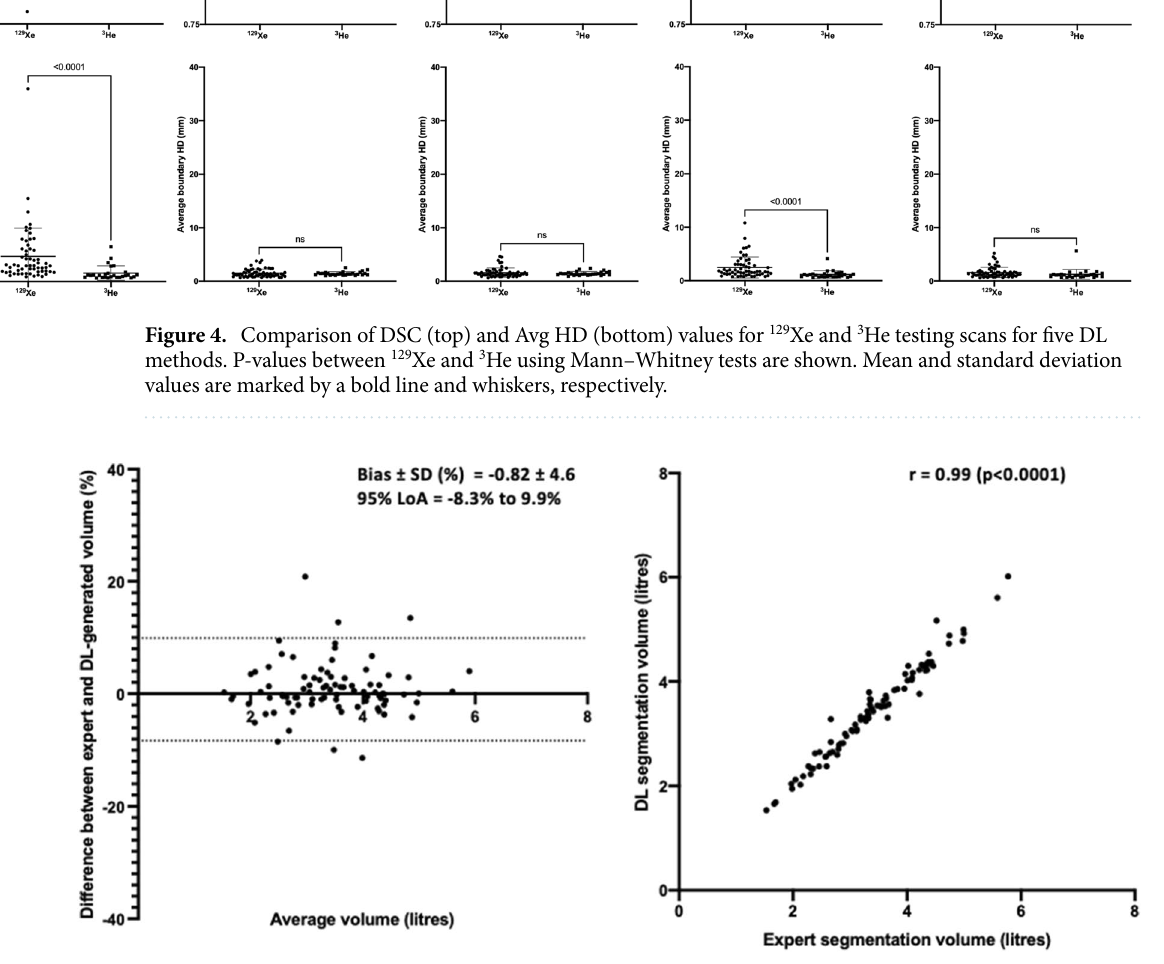
Figure 5. Pearson correlation and Bland–Altman analysis of lung volumes for 86 testing set cases compared to volumes derived from expert segmentations for the combined 3 He and 129 Xe DL